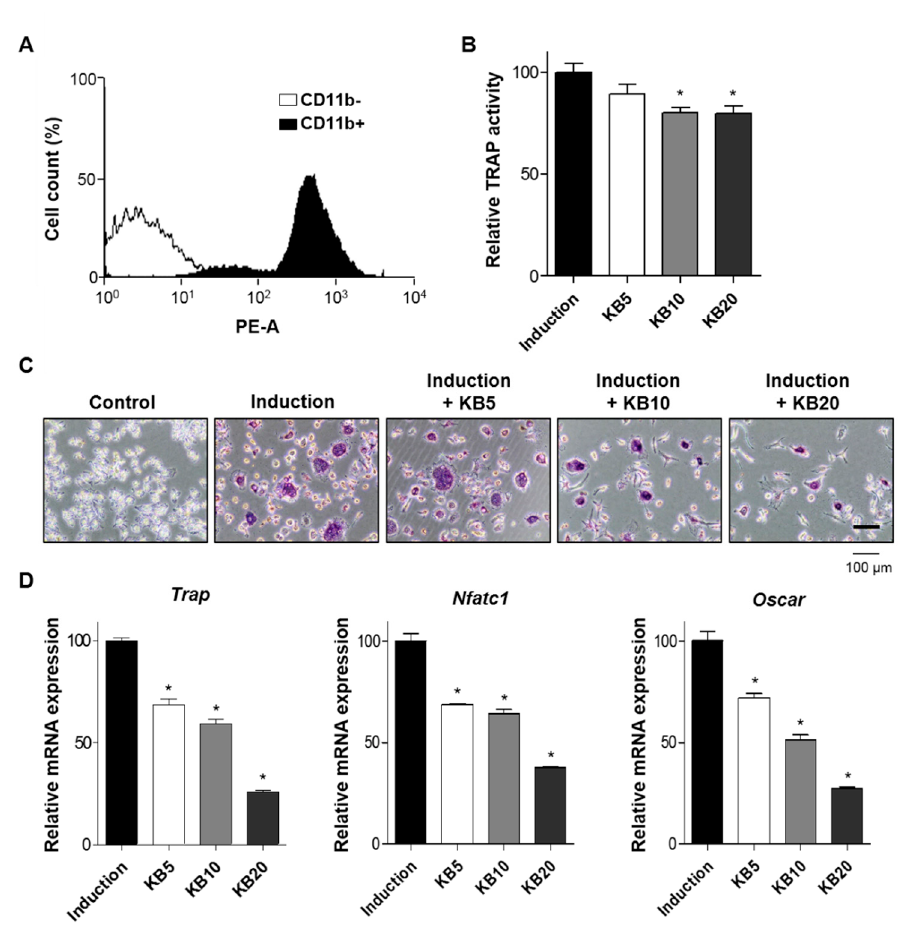
Figure 4. The e ff ects of kukoamine B (KB) on osteoclast di ff erentiation of primary-cultured monocytes. ( A ) The validation of the successful isolation of monocytes from mouse bone marrow. Primary-cultured monocytes were identified by an immunophenotypic analysis with a monocyte-specific surface positive marker (phycoerythrin-conjugated CD11b antibody) using a fluorescence-activated cell sorting analysis. ( B , C ) The assessment of tartrate-resistant acid phosphatase (TRAP) activity in the KB-treated monocyte cells. After the induction of osteoclast di ff erentiation, the cells were treated with KB (5, 10, and 20 µ M) for six days, and then TRAP activity was assessed ( B ). The cells were also stained with a TRAP staining kit, and the di ff erentiated osteoclast cells were visualized under a microscope ( C ). Control: Non-induction of osteoclast di ff erentiation. Induction: Induction of osteoclast di ff erentiation with 30 ng / mL of a macrophage colony-stimulating factor (M-CSF) and 50 ng / mL of a receptor activator of nuclear factor kappa-B ligand (RANKL). ( D ) The mRNA expression levels of the tartrate-resistant acid phosphatase ( Trap ), nuclear factor of activated T-cells cytoplasmic 1 ( Nfatc1 ), and osteoclast-associated immunoglobulin-like receptor ( Oscar ) genes were measured by qRT-PCR. All experiments were repeated three times. *: p < 0.05 vs. Induction (Tukey’s HSD post hoc test,